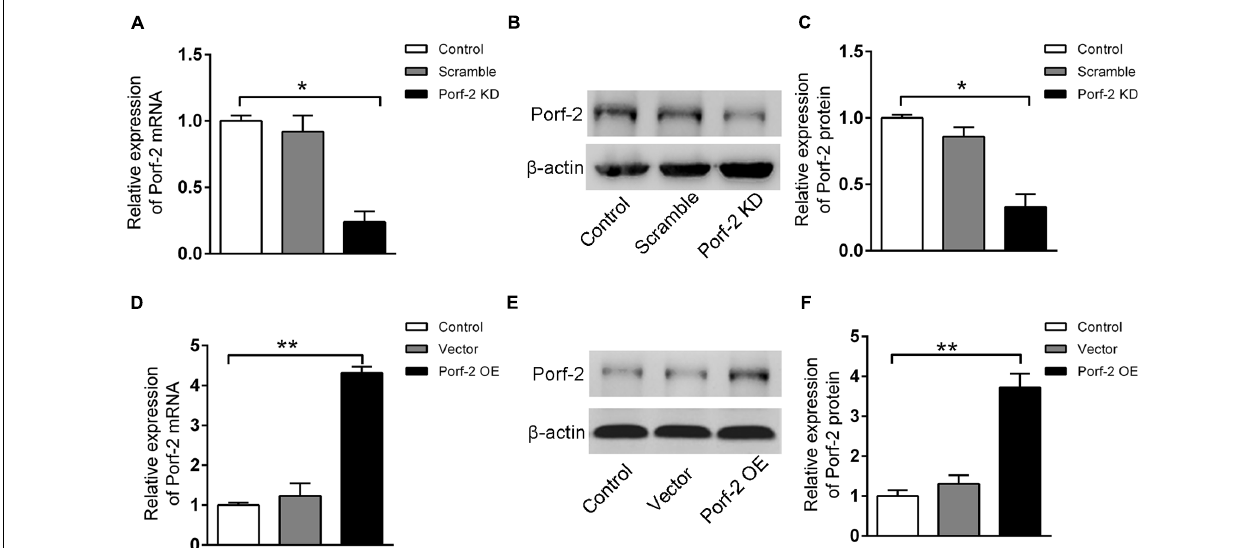
FIGURE 1 | Stable knockdown or overexpression of Porf-2 in neural stem cells (NSCs) after lentiviral transfection. (A) Real-time PCR analysis of Porf-2 mRNA expression after Porf-2 knockdown in NSCs. Scramble, cells transfected with non-targeting shRNA as a negative control; KD, cells in which Porf-2 was knocked down by Porf-2-targeted shRNA. (B) The protein level of Porf-2 was detected by immunoblot after Porf-2 knockdown in NSCs. β -actin was used as an internal control. (C) Quantification of the band intensity of immunoblotting in (B) . The band density was normalized to β -actin signal in the same sample. (D) Real-time PCR analysis of Porf-2 mRNA expression after Porf-2 overexpression in NSCs. OE, overexpression. (E) The protein level of Porf-2 was detected by immunoblot after Porf-2 overexpression. β -actin was used as an internal control. (F) Quantification of the band intensity of immunoblotting in (E) . The band density was normalized to β -actin signal in the same sample. ∗ p < 0.05, ∗∗ p < 0.01 compared with the control group, n = 3.